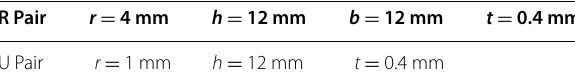
Table 1 Optimization results of the flexure joints